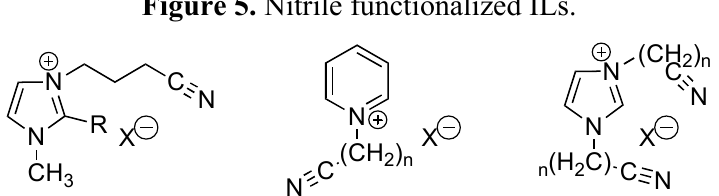
Figure 5. Nitrile functionalized ILs.